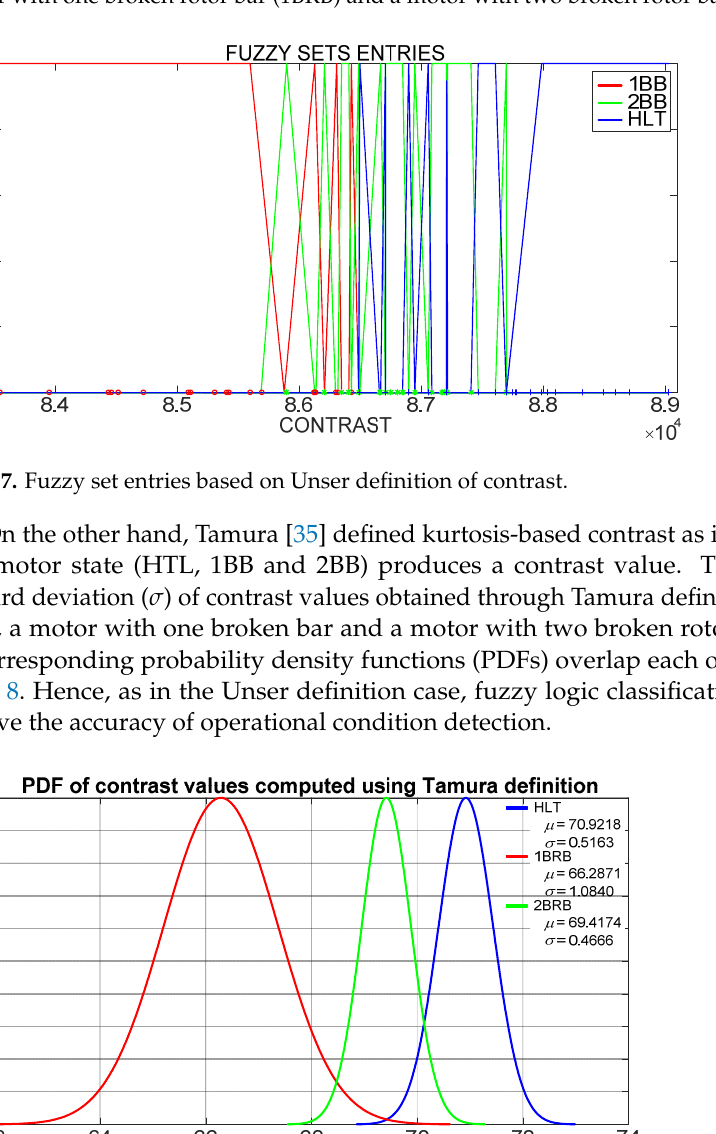
Figure 8. PDFs from contrast values computed through Tamura definition for a healthy motor (HLT), a motor with one broken rotor bar (1BRB) and a motor with two broken rotor bars (2BRB).